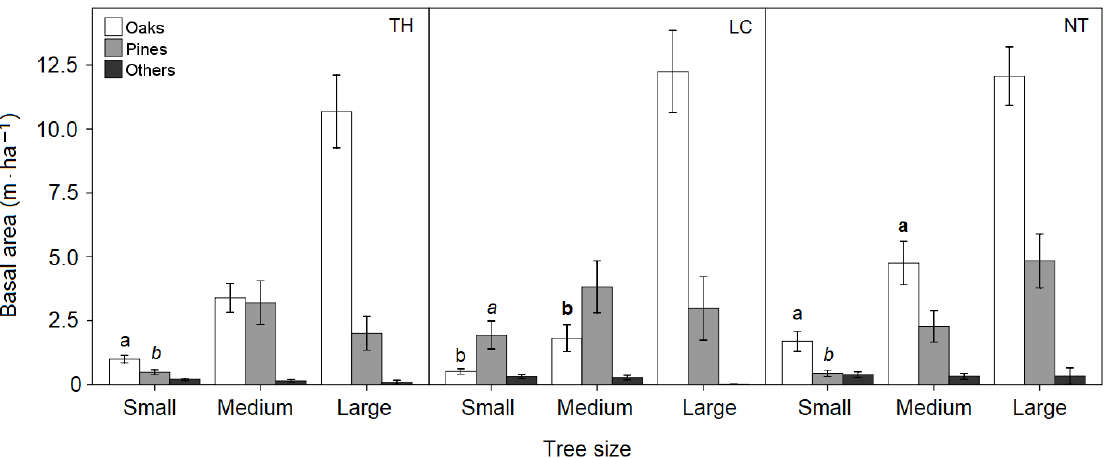
Figure 6. Comparison of the basal area values (mean ± standard error) of trees from each species group (Oaks, Pines and Others) for the same size class (small DBH 5–10 cm, medium DBH 11–30 cm and large DBH > 30 cm) in silvicultural treatments in the Ocotones forest, Chiapas. TH = Thinning II, LC = Liberation cut, and NT = No treatment. Densities that differed significantly ( p < 0.05) are shown with different letters above bars. Normal font for Small Oaks comparisons, italics for Small Pines, and bold for Medium Oaks.